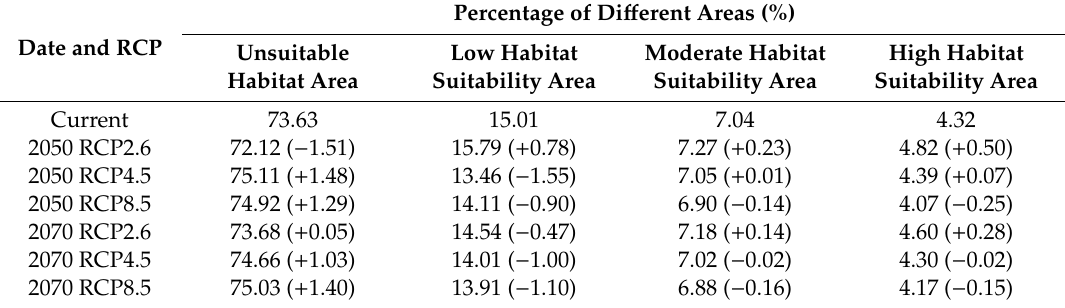
Figure 5. Prediction of the future range of suitable areas for S. noctilio under various representative concentration pathway (RCP) scenarios in 2050 and 2070. Table 2. Percentage land surface area of di ff erent S. noctilio habitat suitability types under various Table 2. Percentage land surface area of different S. noctilio habitat suitability types under various climate climate scenarios.